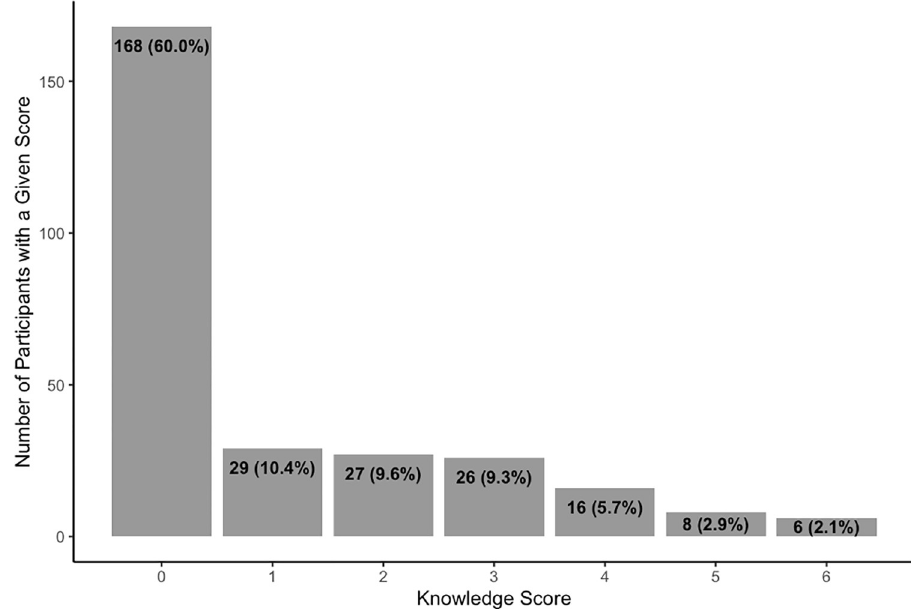
Fig 2. Distribution of HBV knowledge scores at baseline. Score reflects the number of correct responses to 9 statements about HBV symptoms, transmission, and prevention. The average knowledge score was 1.06.